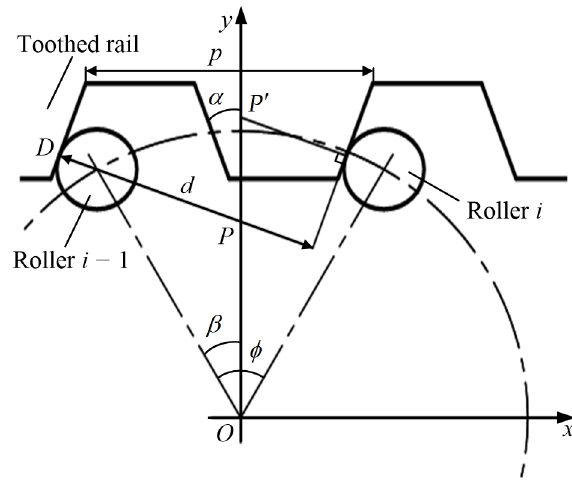
Figure 4. Initial position of the roller gear.